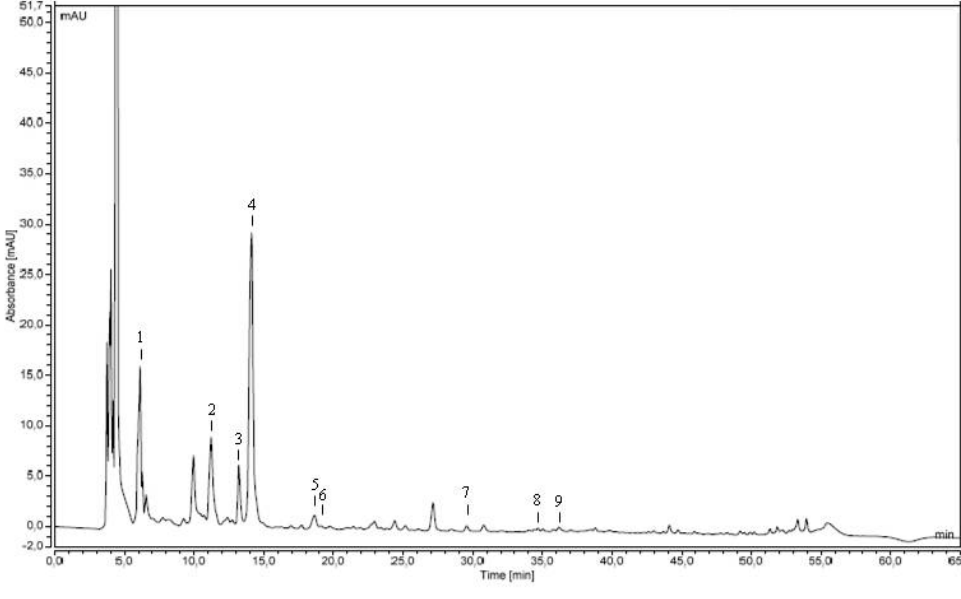
Figure 2. The representative chromatogram of phenolic compounds extracted from the fresh biomass of Spirulina platensis : absorbance at 272 nm. Peak identifications were performed by retention time and UV spectra against commercially available reference compounds. Peaks: gallic acid ( 1 ) catechin ( 2 ), caffeic acid ( 3 ), p -hydroxybenzoic acid ( 4 ), p -coumaric acid ( 5 ), ferulic acid ( 6 ) quercetin ( 7 ), genistein ( 8 ) and kaempferol ( 9 ).